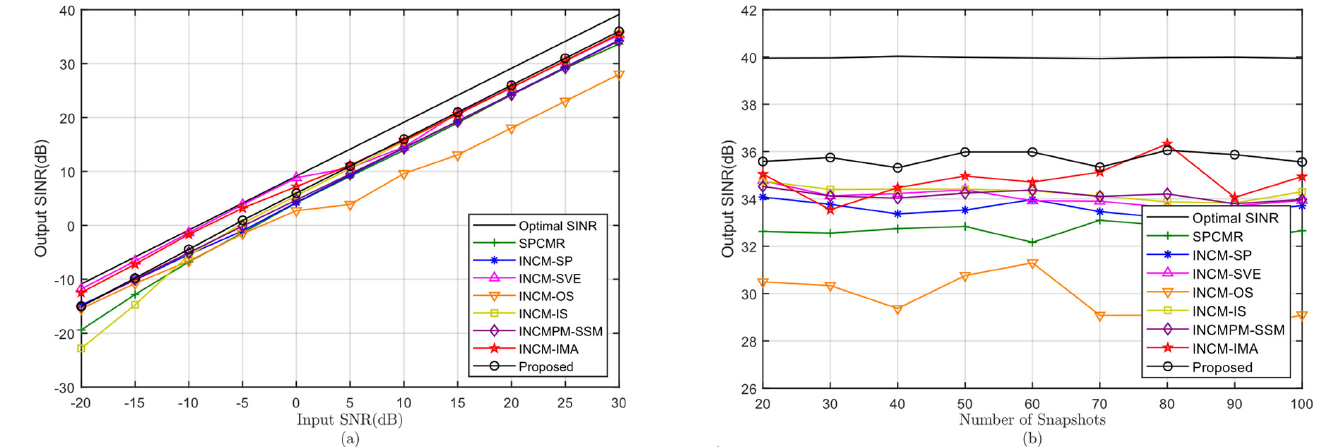
Figure - 3. Example 2: output SINR vs.: ( a ) input SNR; ( b ) number of snapshots. Figure 3. Example 2: output SINR vs.: ( a ) input SNR; ( b ) number of